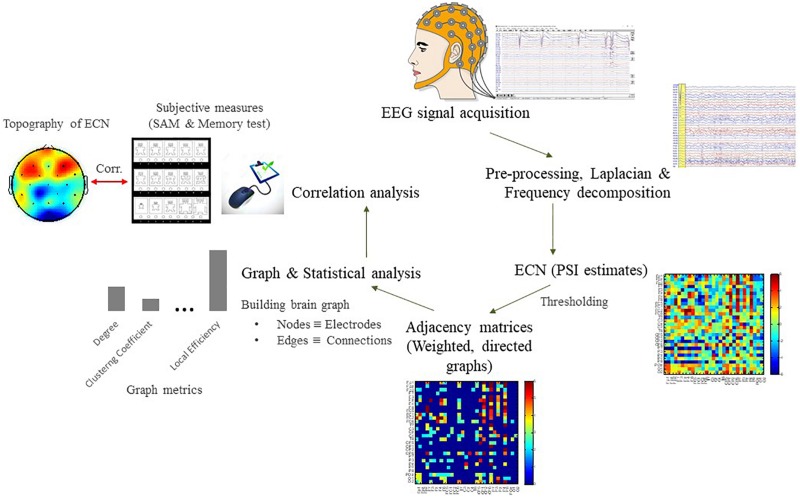
Flowchart for the EEG data analysis pipeline to characterize patterns of effective connectivity network (ECN) based on graph theoretical analysis. See Supplementary Material for results of power spectral density (PSD).